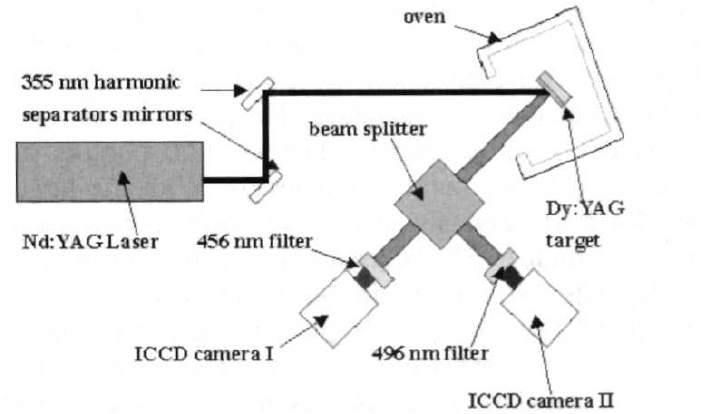
Figure 12. Schematic of the intensity ratio thermal imaging system